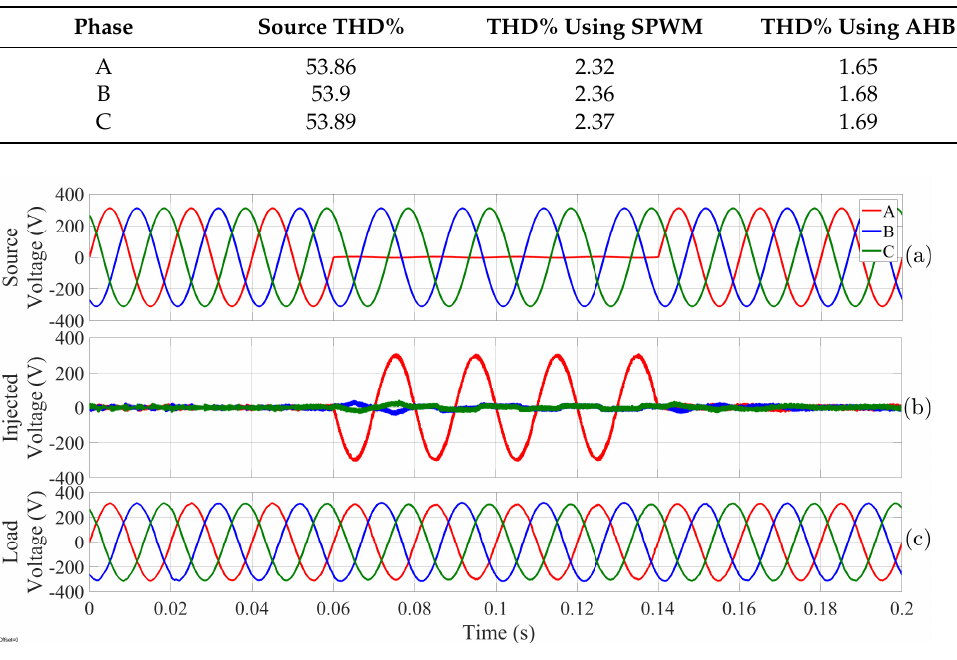
Figure 15. The simulation results of the phase interruption ( a ) Source voltage, ( b ) injected voltage, and ( c ) load voltage. Table 10. The THD for the case of voltage interruption in the first